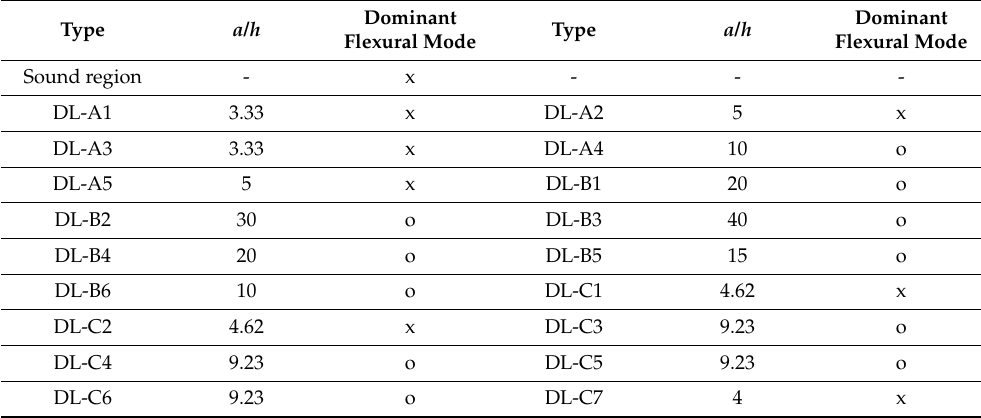
Table 2. Dominant flexural mode according to a/h by defect